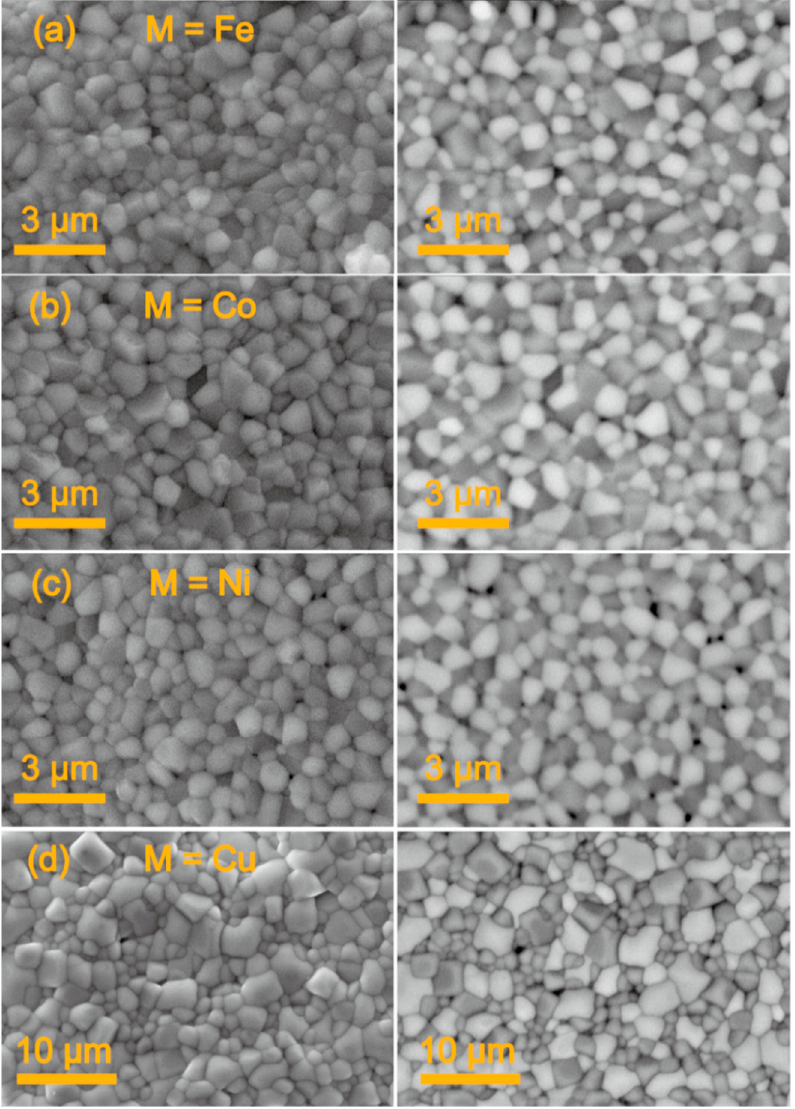
Figure 2. Surface topographies of ( a ) CPFe-PSFA, ( b ) CPCo-PSFA, ( c ) CPNi-PSFA, and ( d ) CPCu- PSFA. Left column is SEM and right column is backscattered scanning electron microscope (BSEM) pictures for the sintered membranes. In BSEM, the perovskite phase (PSFA) grains are in dark color; the CPM grains are in light color.